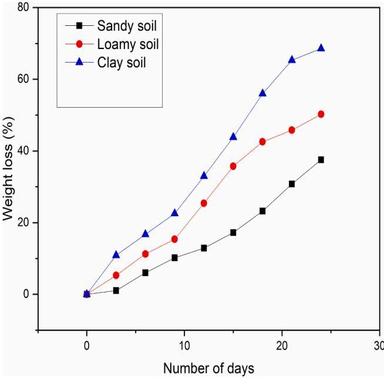
Biodegradability analysis of HRFs.